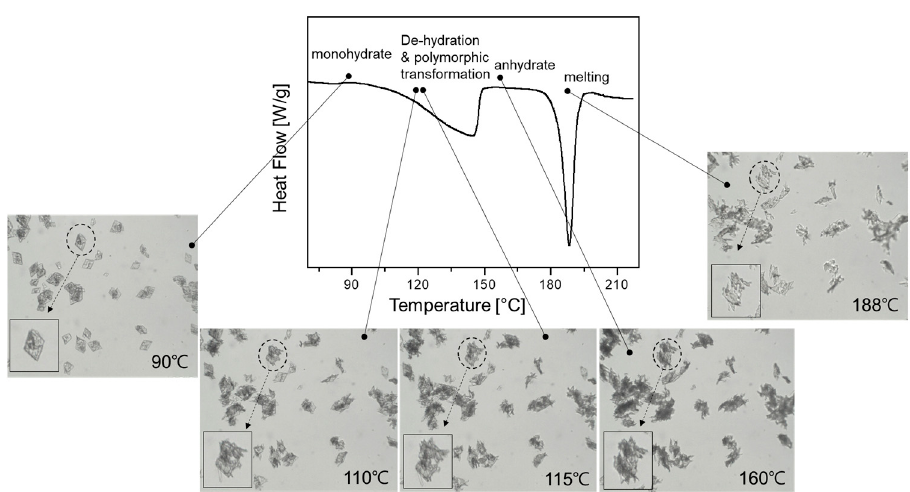
Figure 10. DBE phase transformation diagram utilizing DSC-HSM (heating rate 10 °C /min, temperature range 30 °C– 220 °C ).